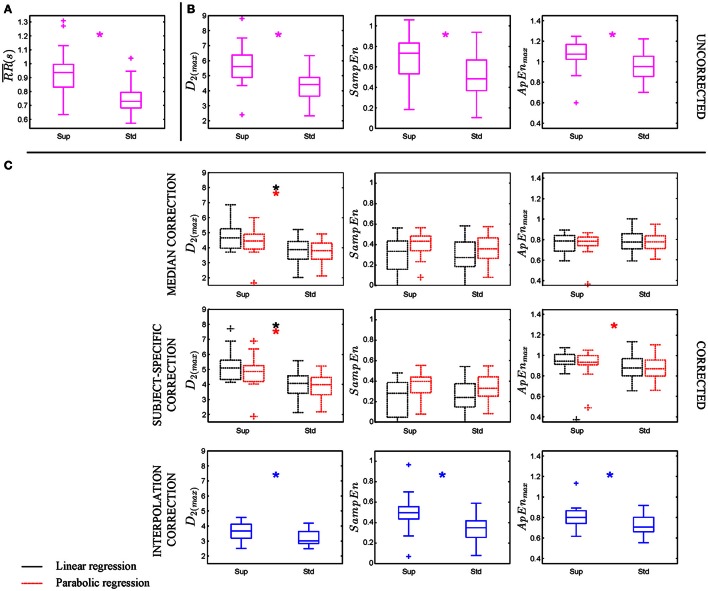
BPC database (22 subjects) was analyzed in which supine and standing positions were compared. (A,B) Illustrate mean RR and uncorrected nonlinear HRV indices while (C) shows HR-corrected nonlinear HRV indices. Asterisks (*) indicates p < 0.05 by Mann–Whitney U-test between supine (Sup) and standing (Std) positions.